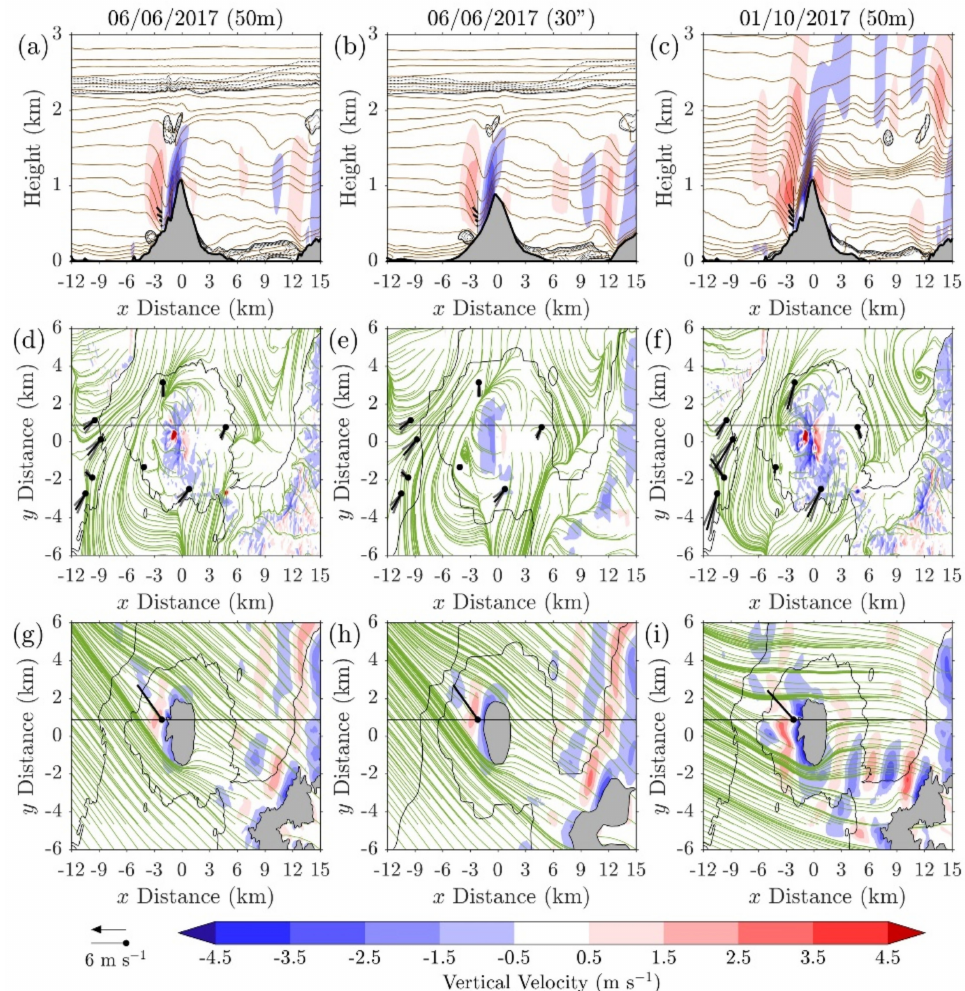
Figure 7. Simulated flow and observations (3–h averages between 0600–0900JST) for the three simulations: ( a , d , g ) June (50~m DEM), ( b , e , h ) June (30” DEM), and ( c , f , i ) October (50 m DEM). First row: Vertical cross–sections along the Doppler lidar site (measuring range shown by the black vertical line) showing vertical velocity (shaded) overlaid with isentropes (brown) and wind vectors (black) based on lidar data. Flow is from the right, aside from areas of flow reversal (black speckled contours). Isentropes plotted every 1 K from 288 K. Second row: Surface flow (1 st model level, terrain–following) showing vertical velocity (shaded), overlaid with streamlines (green) starting at every 1 km in both directions, based on horizontal wind components. Surface observations/errors shown as black/gray wind vectors. Third row: As the second, but showing results interpolated at 600 m above sea level. Wind vector based on lidar data. Note that the y–axis is exaggerated in all